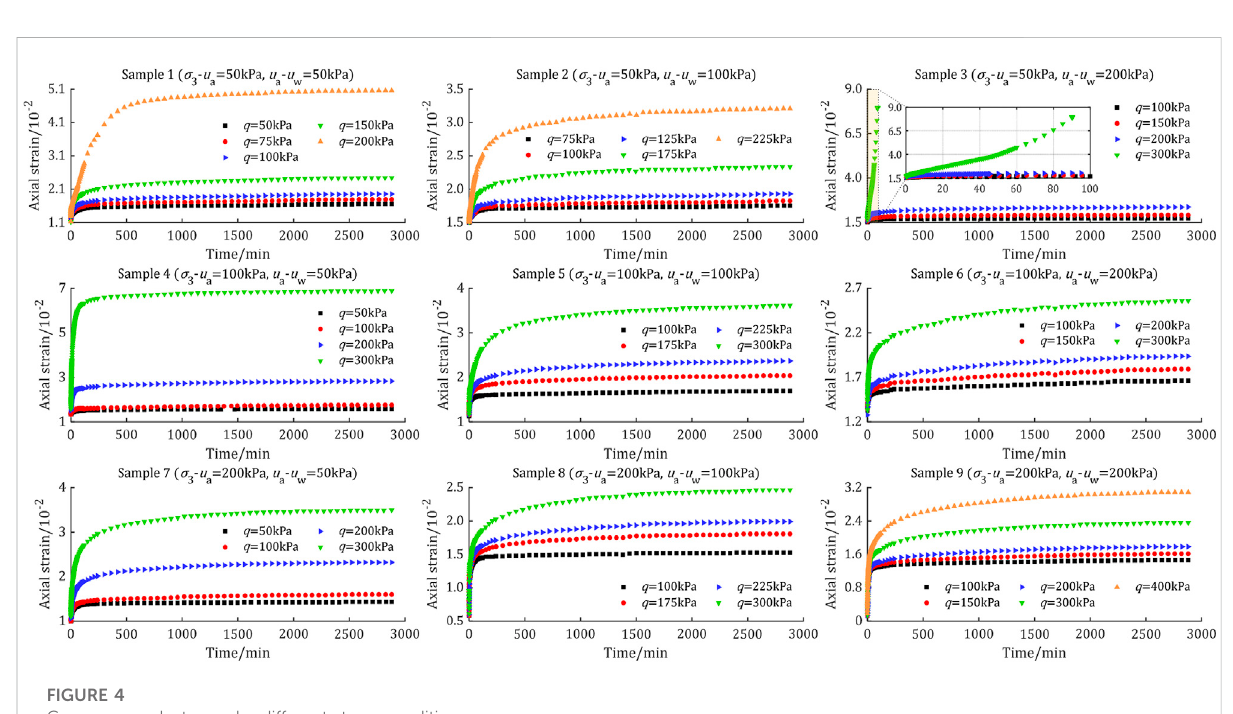
FIGURE 3 Measured creep curves under step loading.